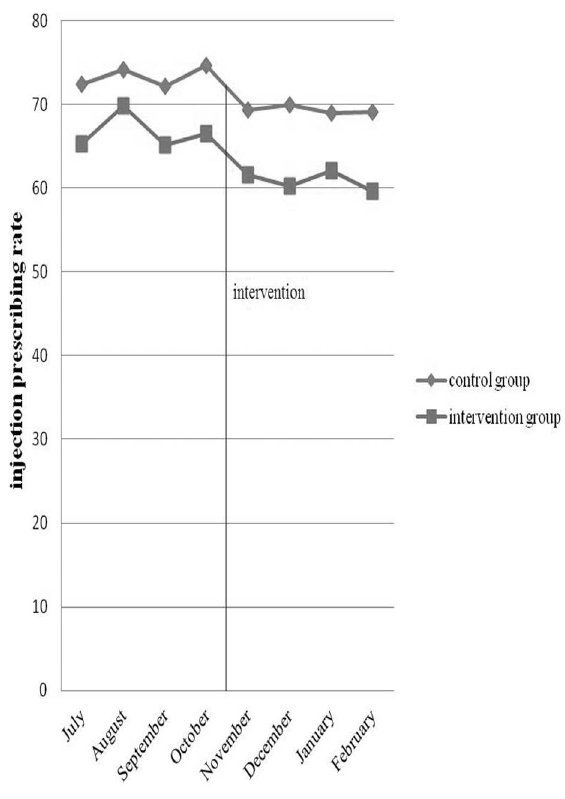
Figure 1. Change in injection prescribing rate by month.